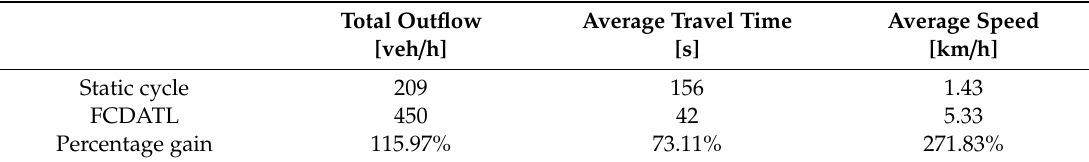
Table 2. Experimental results for the whole intersection.